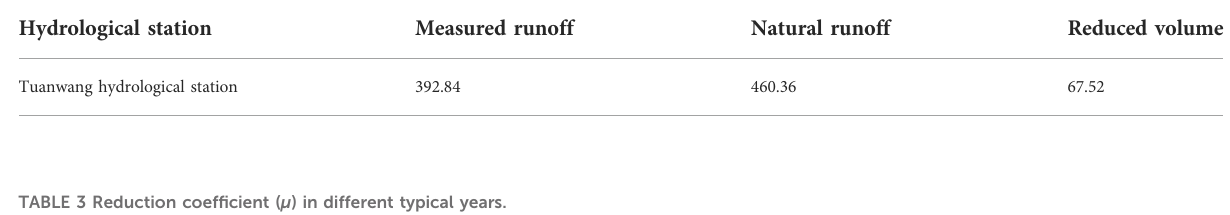
TABLE 2 Comparison of the measured runoff and reduced runoff in 1960 – 2016 (Unit: million m³).